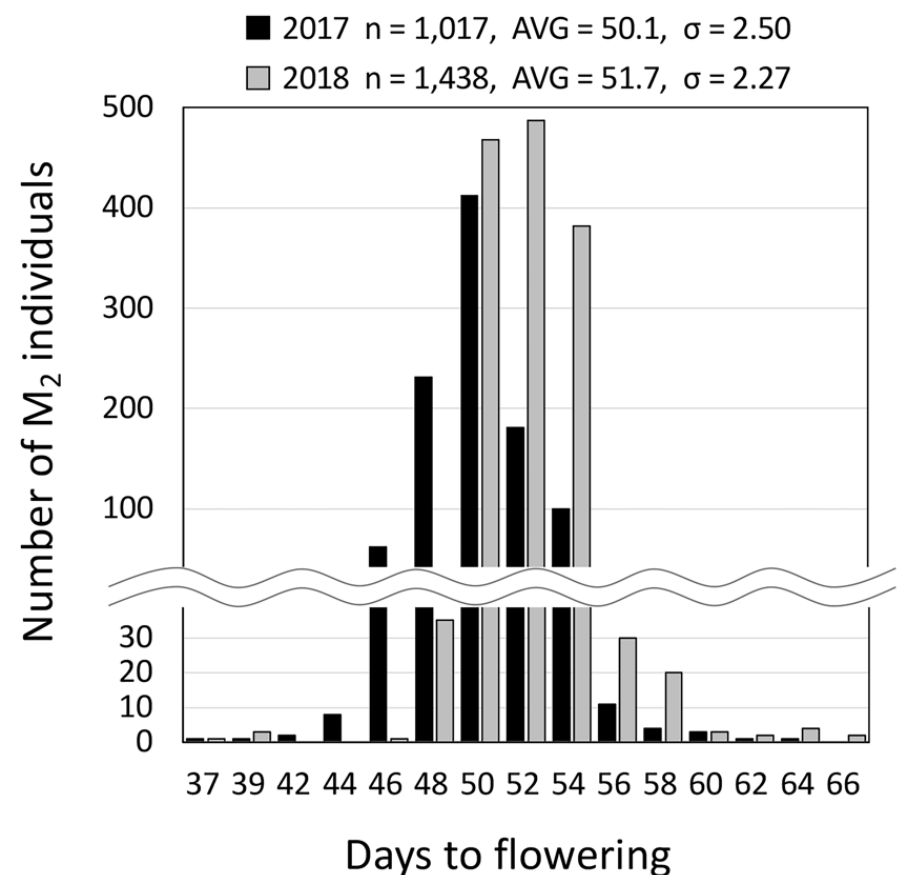
Figure 2. Frequency analysis of the days to flowering for the M 2 populations in 2017 (n = 1,017) and 2018 (n = 1,438). The M 2 populations grown in 2017 and 2018 are progenies of the M 1 plants grown in 2016 and 2017, respectively. The average (AVG) and standard deviation ( σ ) data are shown at the top of the figure.